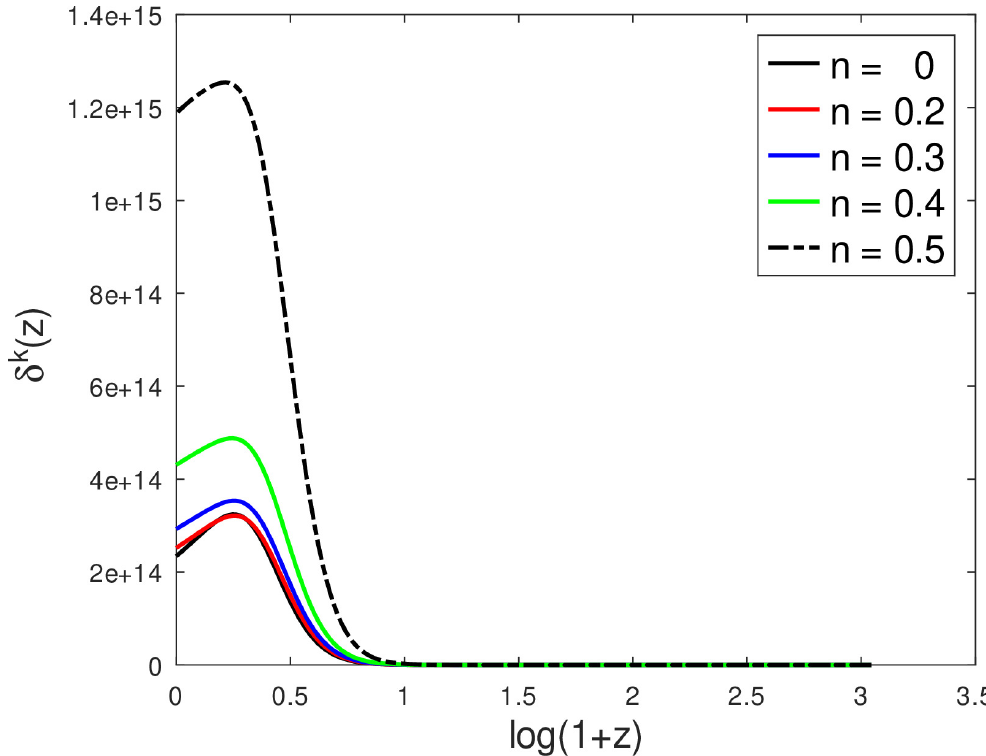
Figure 12. The variation of the matter density perturbations δ k ( z ) for a viscous Bianchi type-V cosmological model vs. redshift for γ = 50, α = 0.3, β = 1 and different values of n .